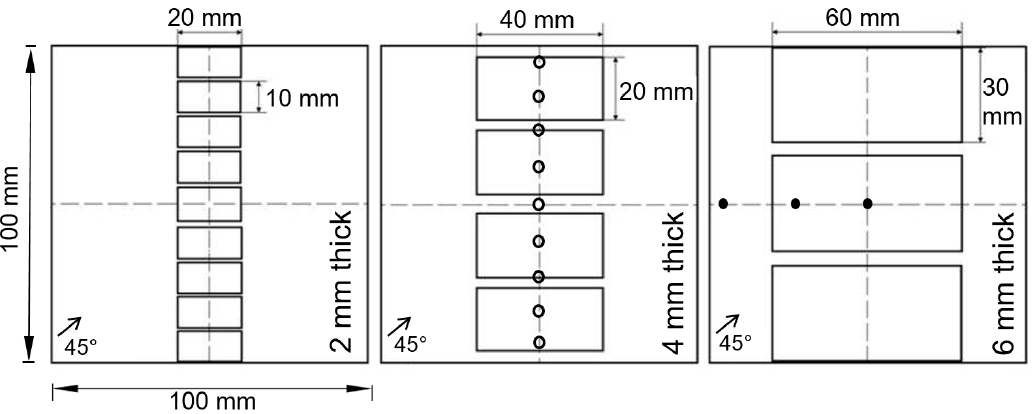
Figure 3. Size and position of the ILSS-specimens cut from the thermally loaded panels: o: represents the positions for the IR measurements (sample backside), • : positions of thermocouples (sample backside).